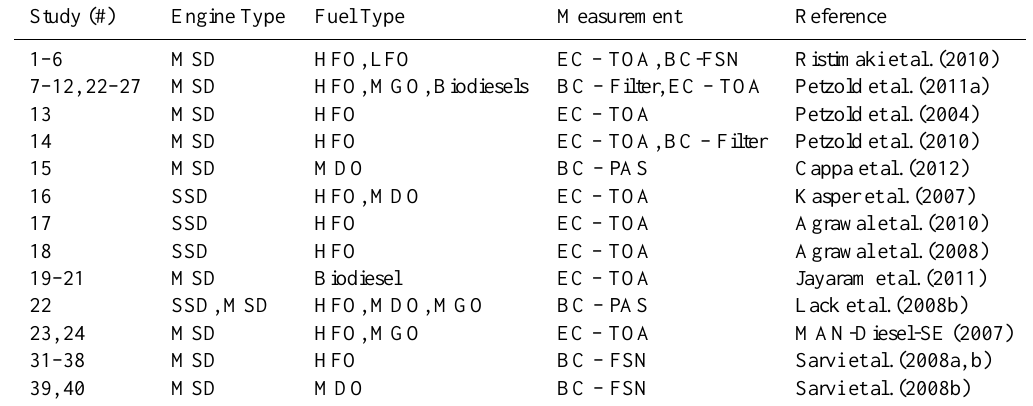
Table 1. Studies on the effect of engine load on BC emissions found in literature.